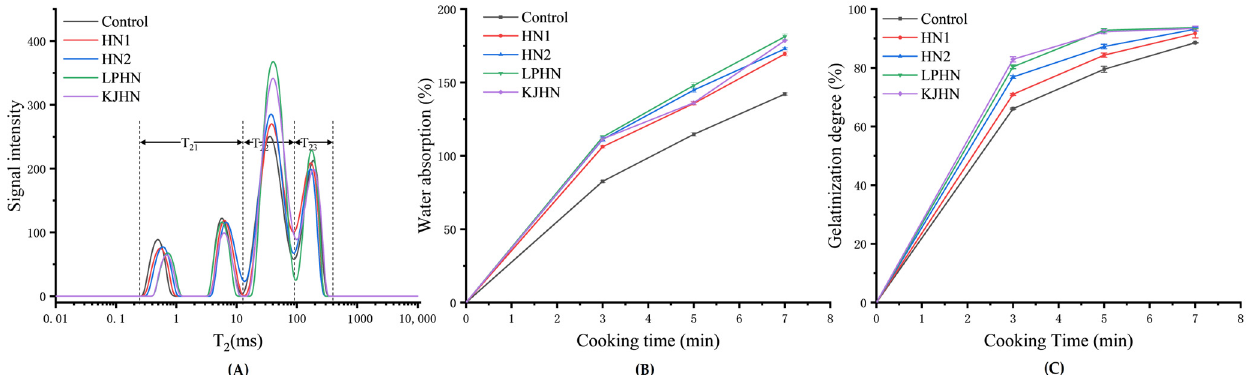
Figure 1. Effect of fermentation methods on the water distribution characteristics ( A , B ) and degree of gelatinization of noodles ( C ) during cooking. Control, unfermented noodles; HN1, hollow noodles 1; HN2, hollow noodles 2; LPHN, Lactobacillus plantarum fermented hollow noodles; KJHN, Koji fermented hollow noodles.